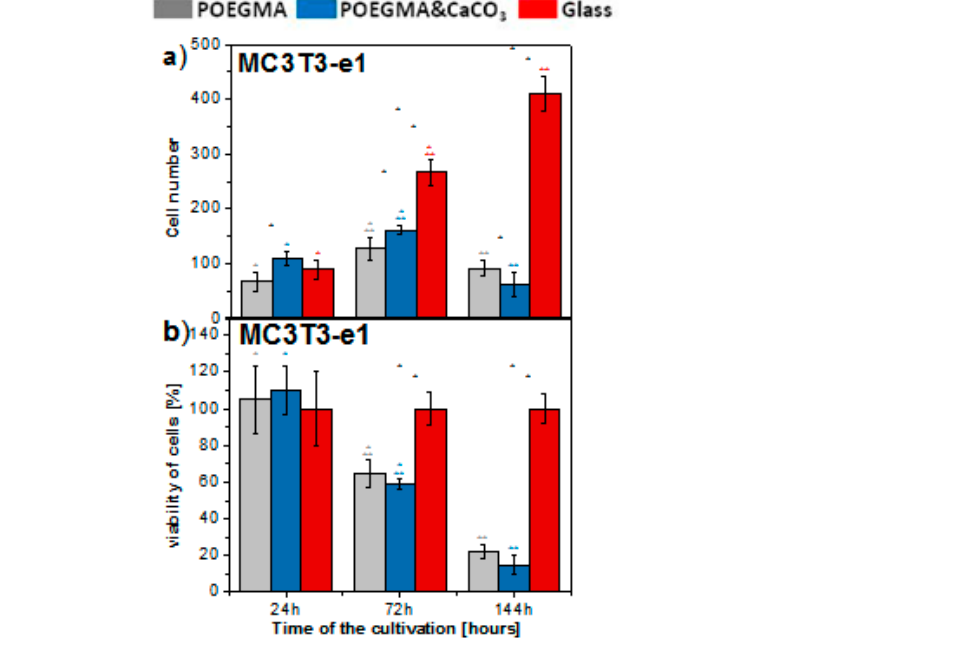
Figure 12. Impact of glass surface, POEGMA and POEGMA-grafted brush coatings with incorporated CaCO 3 NPs on the amount ( a ) and viability ( b ) of osteoblastic cell line MC3T3-e1 (*, ** significantly different from each other, p < 0.05). Data are presented as a mean ± standard deviation (SD) from n = 10 repetitions.